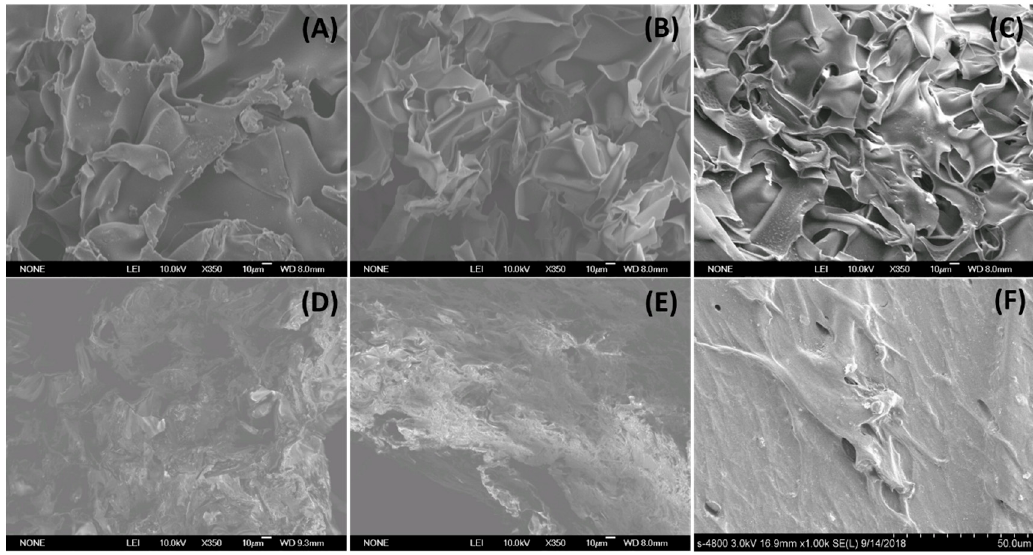
Figure 1. SEM micrographs of NIPAM-based pure cryogels with ( A ) 3% ( B ) 5% and ( C ) 7% cross- linker, ( D ) Ag hybrid cryogels with 3% crosslinker, ( E ) Pd hybrid cryogels with 3% crosslinker and ( F ) NIPAM-based pure hydrogel with 3% crosslinker.